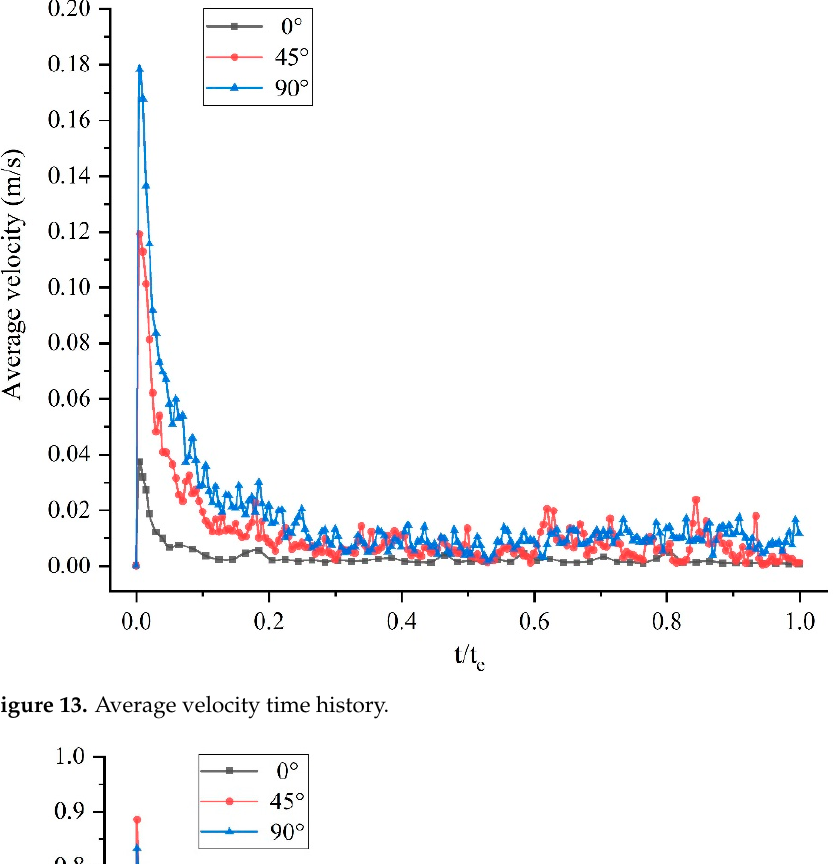
Figure 13. Average velocity time history.